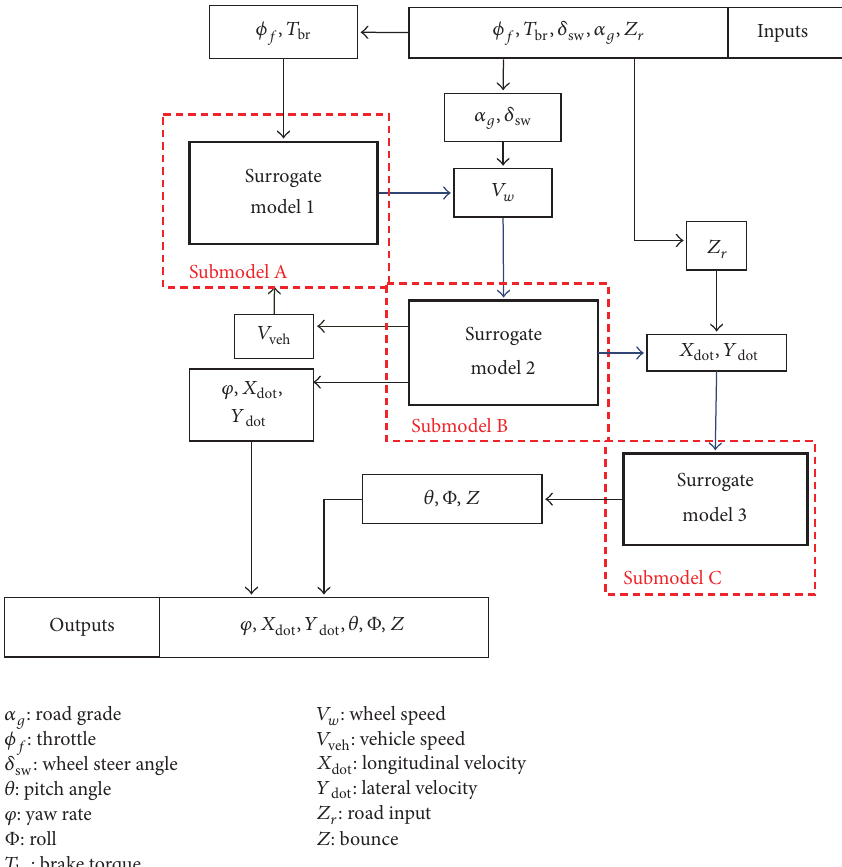
Figure 7: Initial decomposition results for the global surrogate-based modeling of UTMVDM.